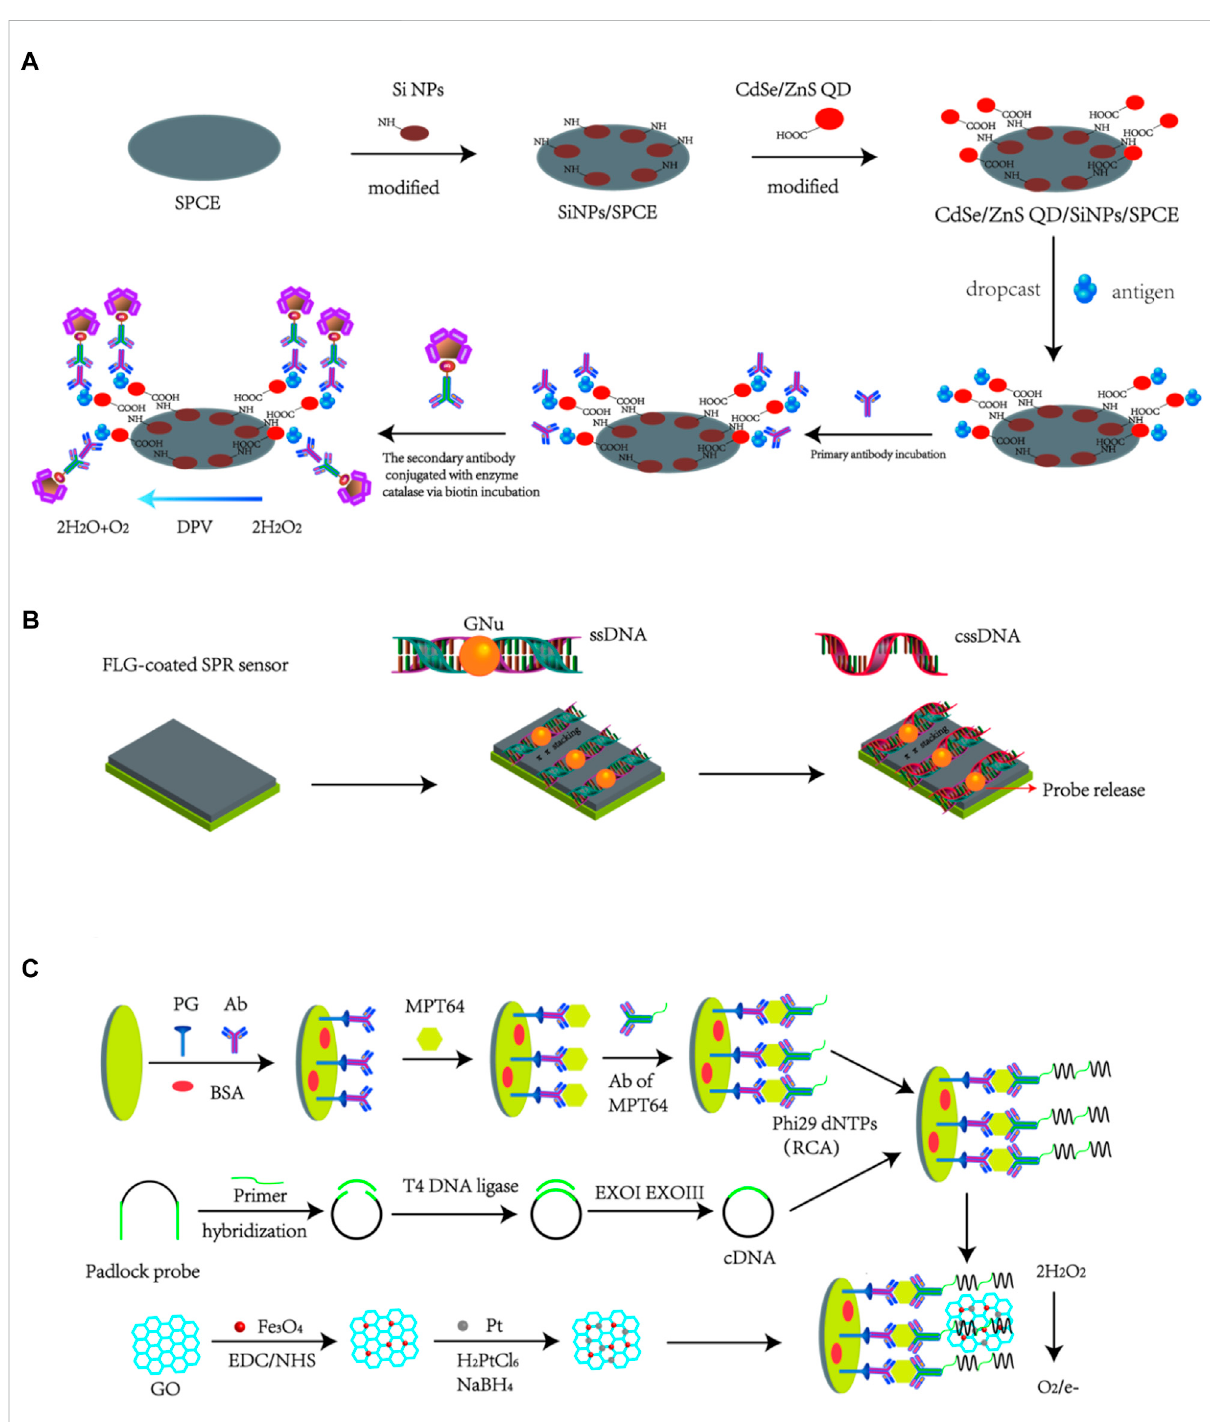
FIGURE 2 Basicapproachestodesignnanobiosensors: (A) Modi fi cationofnanoparticlesontoelectrodesurfacestoconstructfunctionalelectrode-based biosensors(MohdBakhorietal.,2019). (B) Designofnanosystemstoconstructnanoprobesthatcanbeusedfornanobiosensorapplication(Prabowo et al., 2021). (C) Hybrid method to construct Nanobiosensors using both approaches (A,B) (Gou et al.,